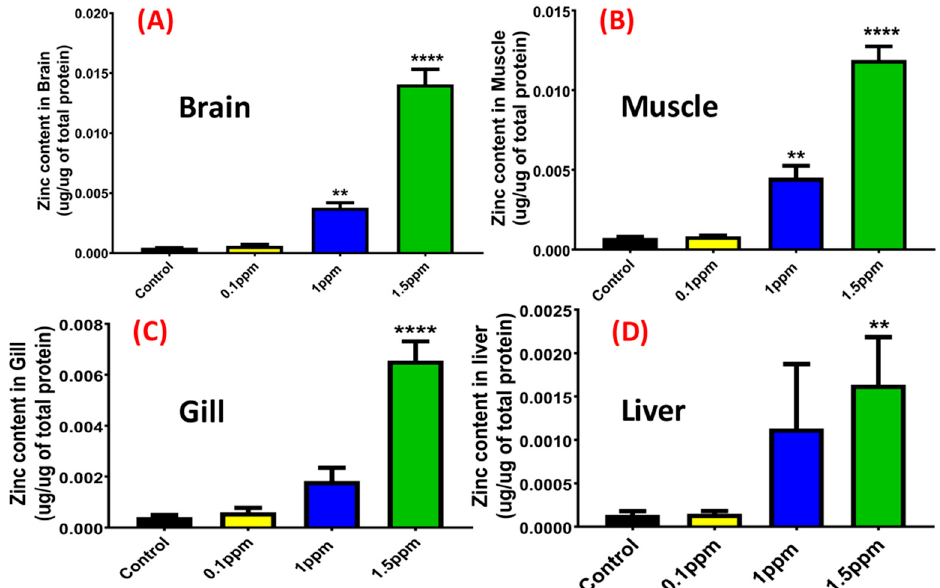
Figure A2. Comparison of zinc levels in different tissues after chronic exposure to ZnCl 2 at different concentrations for 21 days. Adult zebrafish were incubated with different concentrations of ZnCl 2 , and the relative amounts of zinc accumulation in ( A ) brain, ( B ) muscle, ( C ) gill, and ( D ) liver tissues were measured using enzymatic assays. Data are represented as means ± SEM. Statistical analysis was compared to control using a t -test (** p ≤ 0.01; **** p ≤ 0.0001). Table A1. Comparison of present study with other animal models exposed to ZnCl 2 .